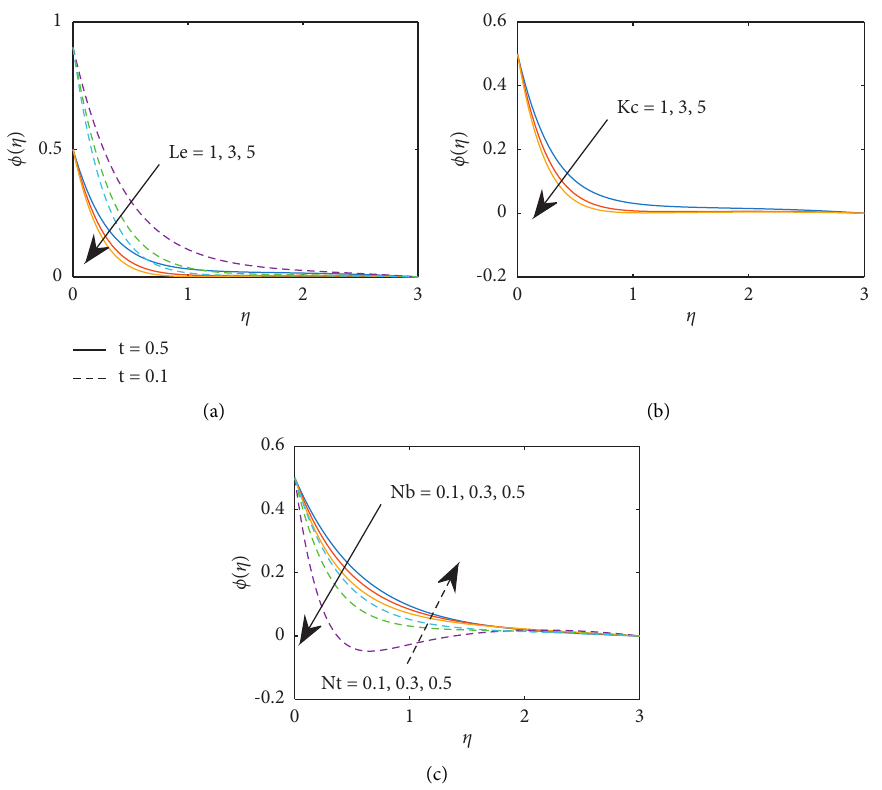
Figure 14: Impact of (a) Le